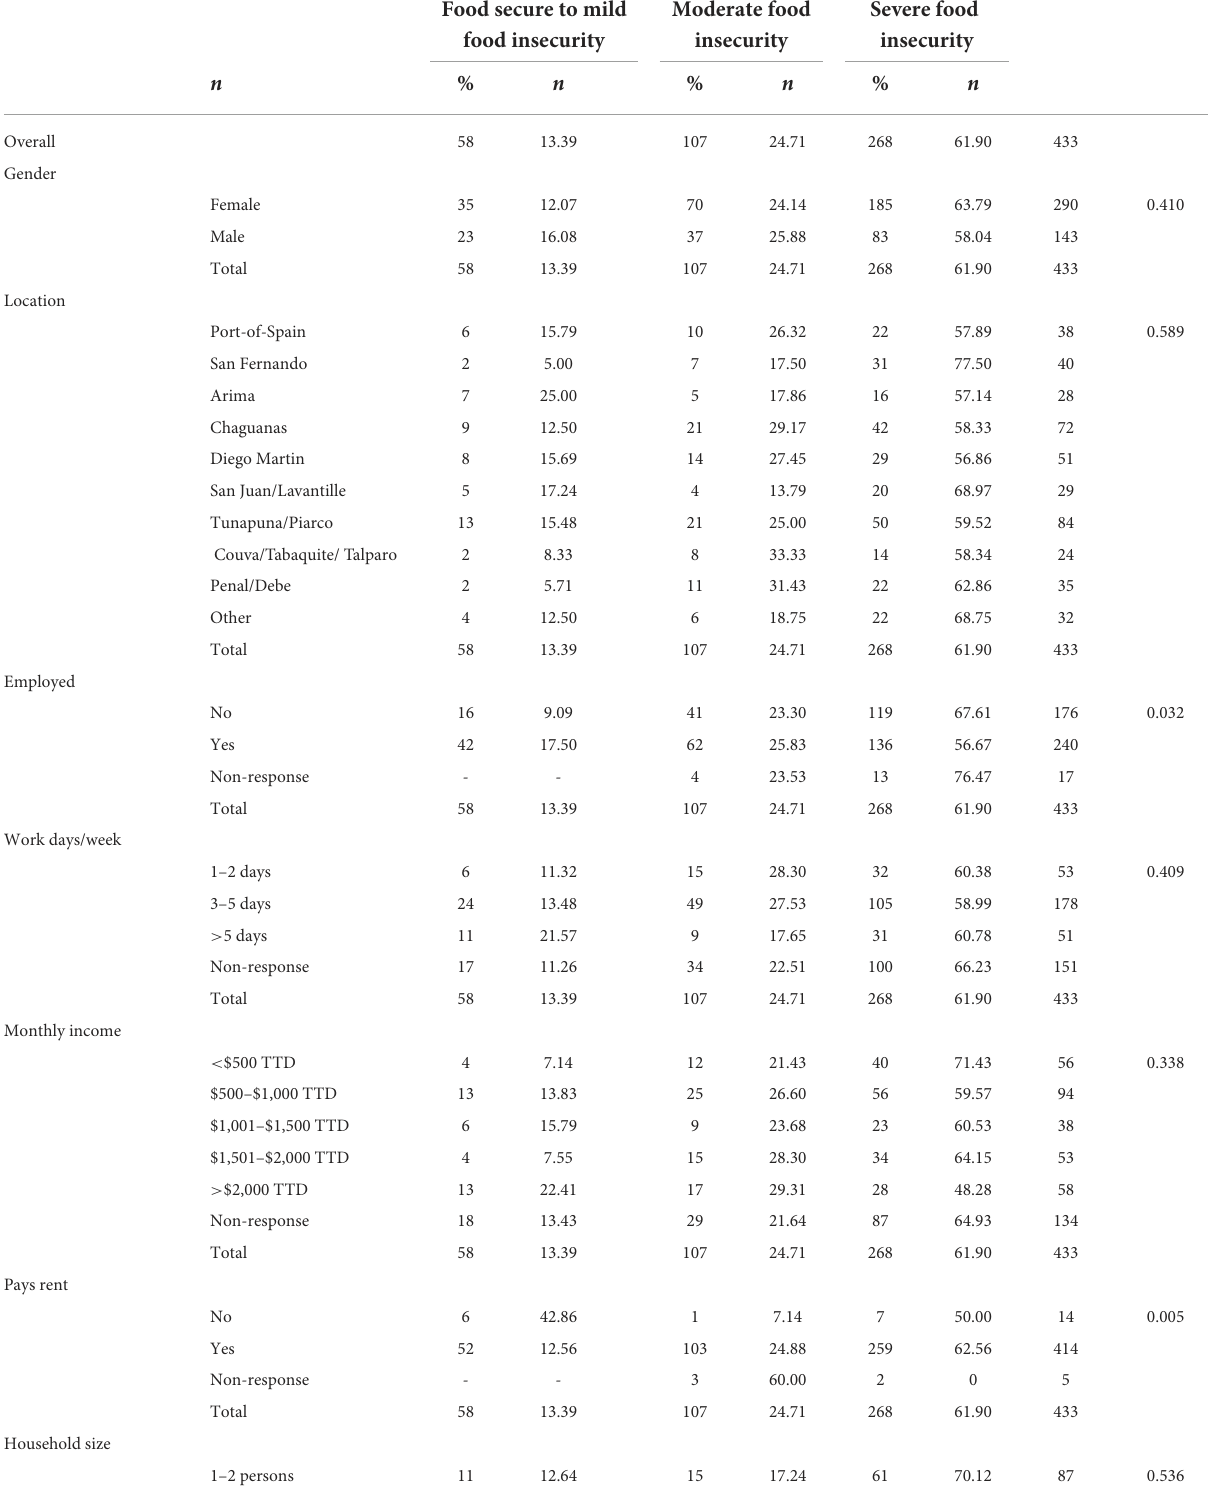
TABLE 3 Proportion of food insecurity experience scale according to sociodemographic and economic